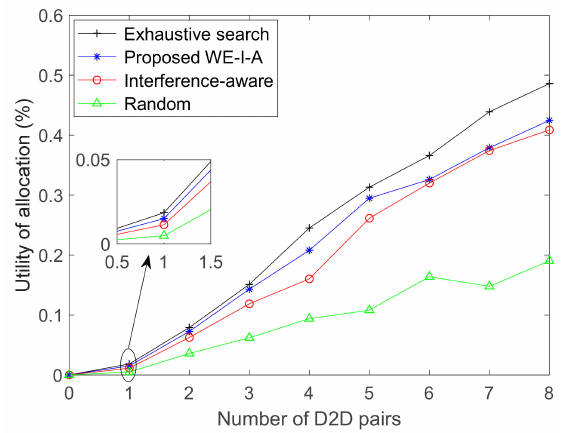
Figure 9. Utility of resource allocation for di ff erent allocation algorithms in case of α =